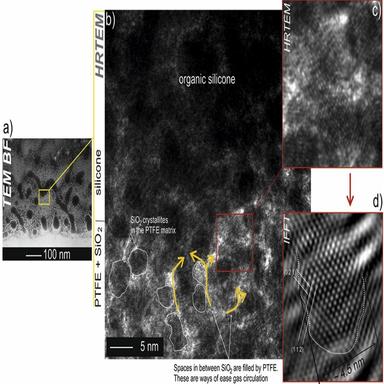
Microstructural characterization of ZONES 1 and 2 of the coating using HRTEM: a). TEM BF image within the marked area of the HRTEM analysis; b). HRTEM image of the ZONE 1-ZONE 2 interface; c). HRTEM image of the silicone nano-crystallite; and d). IFFT image of the silicone nano-crystallite obtained from the 'c)' image by the application of a twin-oval mask.